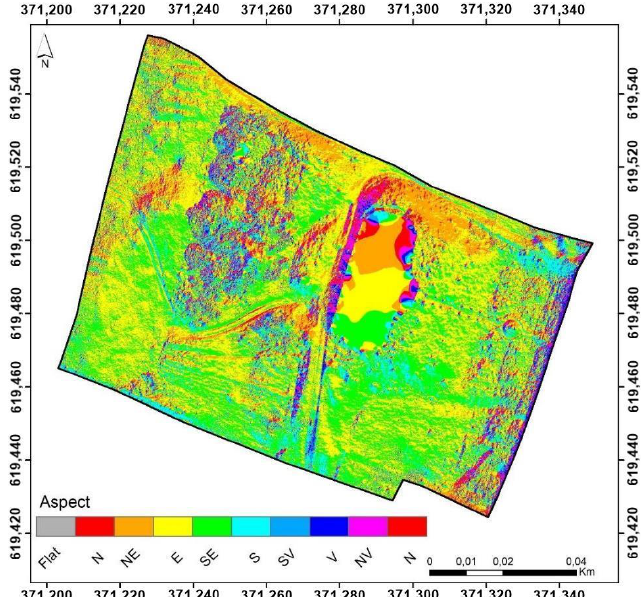
Figure 16. Aspect illustration.